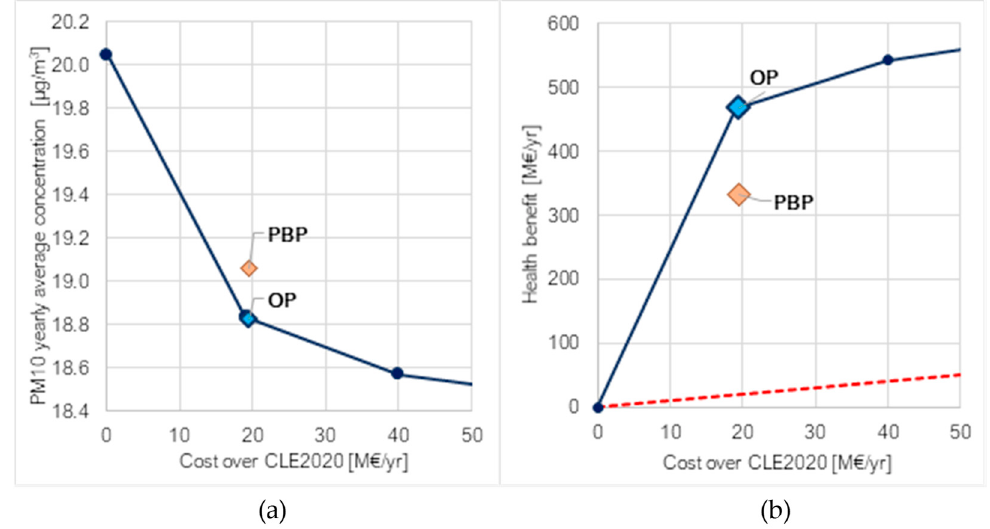
Figure 6. ( a ) PBP and OP in the objective space, zoom on costs between 0 M€/yr and 50 M€/yr. ( b ) cost–benefit analysis, zoom on costs between 0 M€/yr and 50 M€/yr.